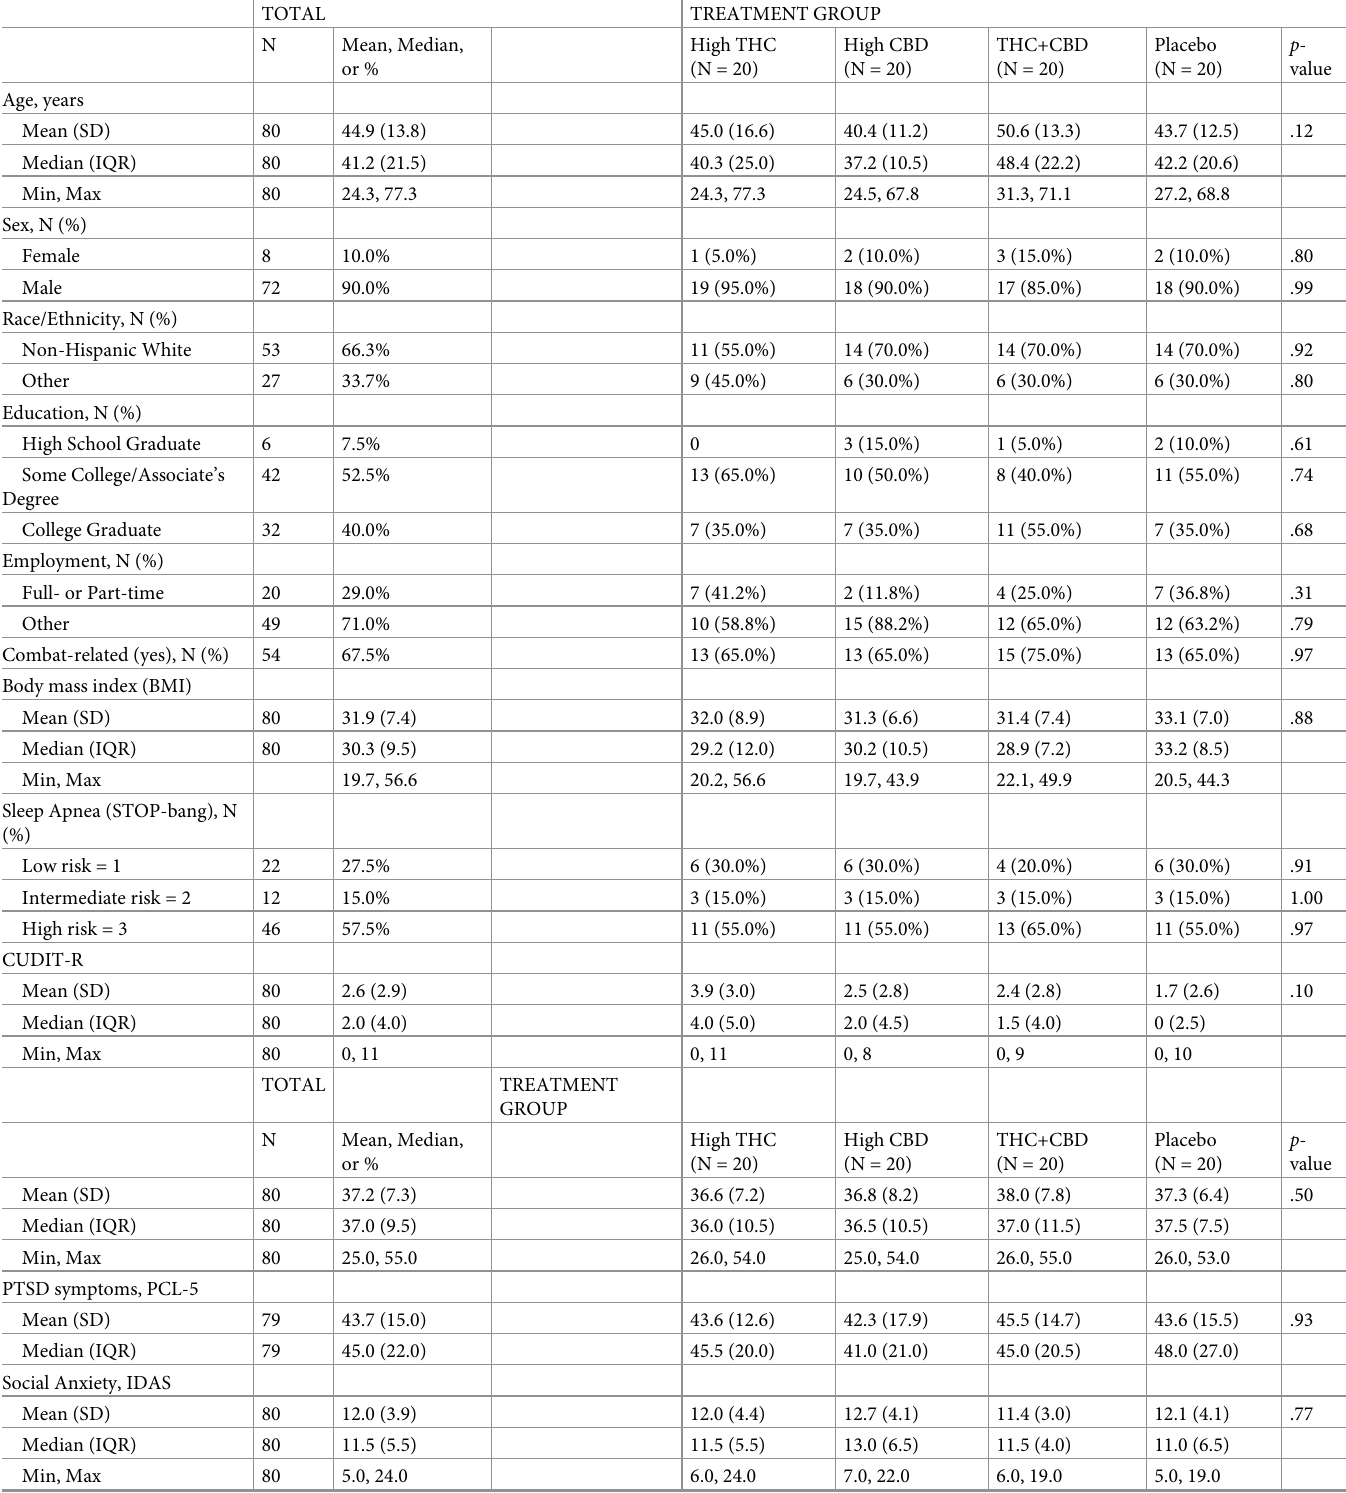
Table 2. Baseline characteristics by treatment